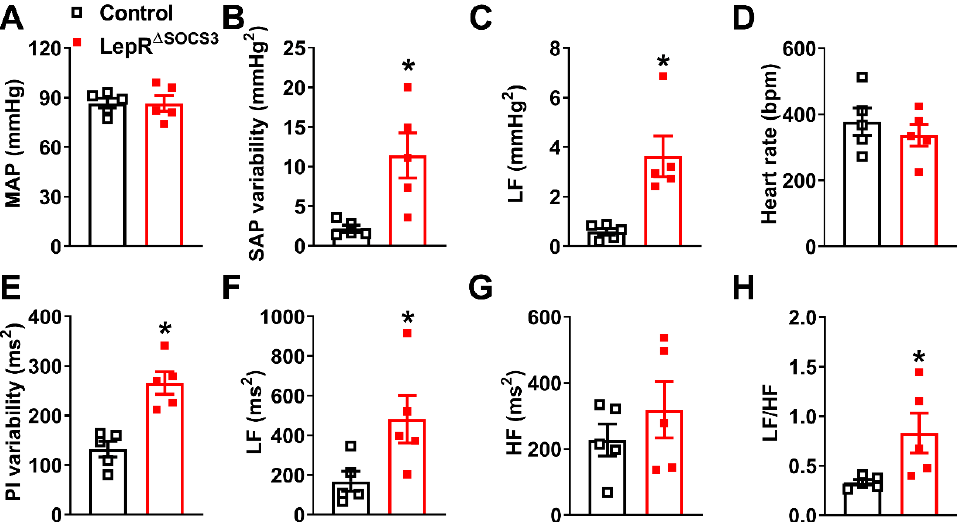
Figure 6. Increased sympathetic activity to the vasculature and heart in LepR ∆ SOCS3 mice. ( A – C ) Mean arterial pressure (MAP), systolic arterial pressure (SAP) variability and low-frequency (LF) variability of the SAP in approximately 8-month-old control ( n = 5) and LepR ∆ SOCS3 ( n = 5) mice. ( D – G ) Heart rate (HR), pulse interval (PI) variability and LF and high-frequency (HF) variability of the PI. ( H ) Sympathovagal balance (LF/HF ratio) of PI variability. Mean ± SEM. * p < 0.05 control vs. LepR ∆ SOCS3 ( t -test).